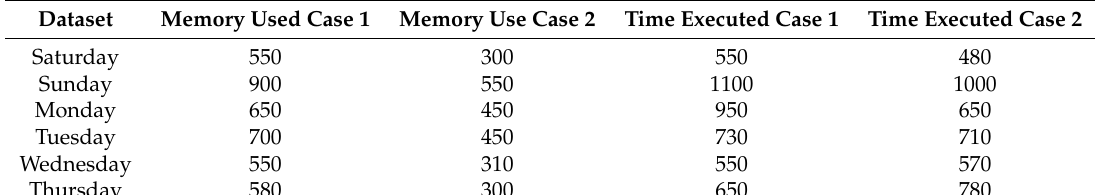
Table 4. The memory profiles of LSTM model on ISCX dataset.